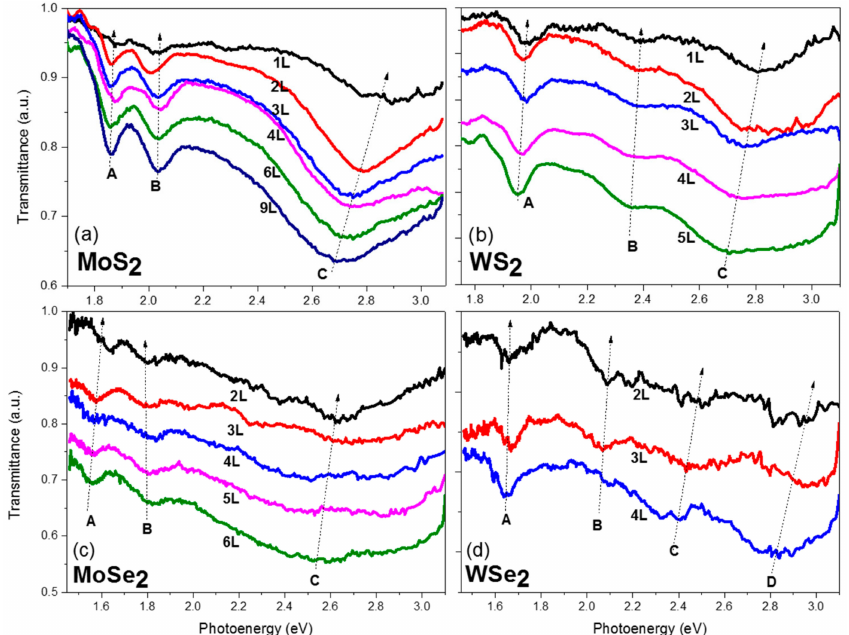
Figure 5. Transmission spectra of the same few-layer ( a ) MoS 2 , ( b ) WS 2 , ( c ) MoSe 2 , and ( d ) WSe 2 flakes as in Figure 4. The spectra are vertically shifted for visual clarity. The dotted arrow lines are guides for the